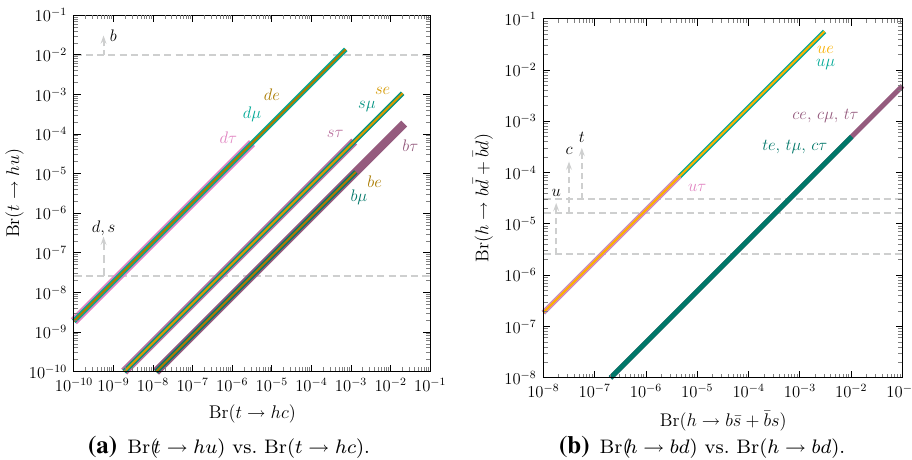
Fig. 2 FCNCprocessesinBGLmodels[28].Thetwo-letterlabelasso- ciated to each line, e.g. “ s μ ”, corresponds to the BGL model. The hor- izontal dashed lines are “naive” upper bounds (a factor 10 to 100 too